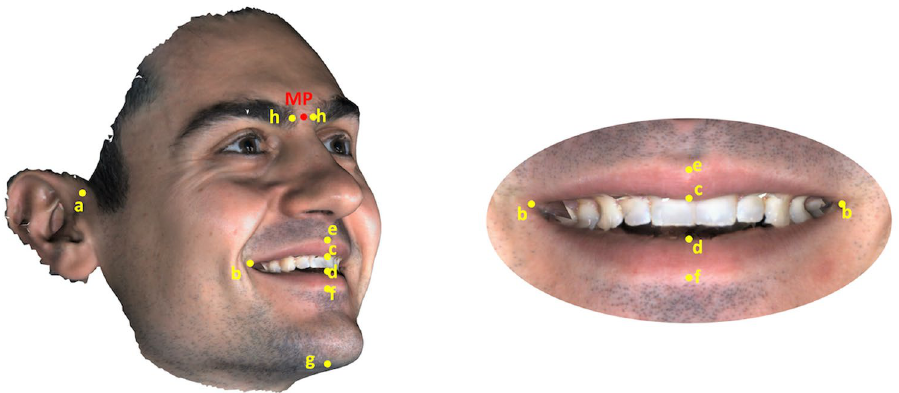
Figure 1. Selected landmarks on 3D images: ( a ) Right and left most lateral facial point (at the intersection where the outer outline of the ear connects to the face); ( b ) Right and left corner of the mouth; ( c ) Upper stomion (the midpoint of the upper lip inferior border); ( d ) Lower stomion (the midpoint of the lower lip superior border); ( e ) Upper vermillion midpoint (the midpoint of the upper lip superior border); ( f ) Lower vermillion midpoint (the midpoint of the lower lip inferior border); ( g ) Menton (the most inferior point of the median plane of the chin); ( h ) Right and left most median point of the upper eyebrow ridge. (Image was created using Viewbox 4 software (version 4.1.0.1 BETA, http://www.dhal.com/viewb oxind ex.htm). The projection of the midpoint between the right and left most median points of the upper eyebrow ridge on the surface image was considered the most superior midline point of the face (point MP) and was used to define facial height.